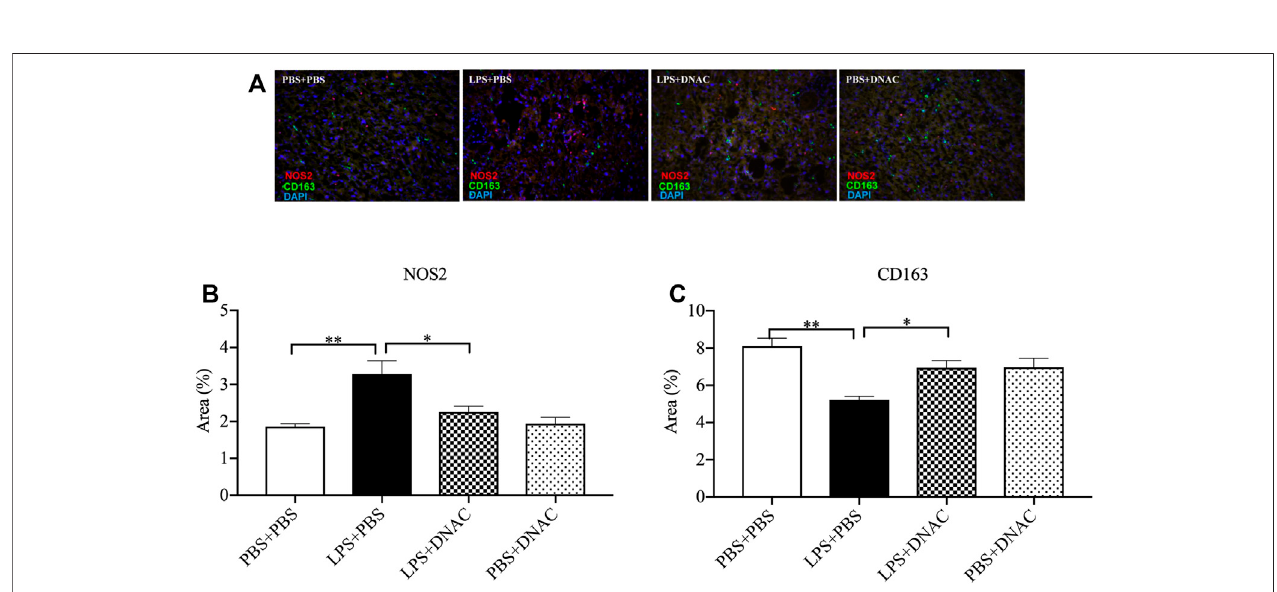
FIGURE 4 | Immunohistochemical staining (IHC) of M1 and M2 macrophages in the placenta following exposure to intrauterine in fl ammation and maternal dendrimer-basedN-AcetylCysteine(DNAC)treatment.Atembryonic(E)day17,pregnantCD-1miceunderwentamini-laparotomyinthelowerabdomenforintrauterine injection of lipopolysaccharide (LPS). One hour later, dams received intraperitoneally injection of DNAC or phosphate-buffered saline (PBS). Placentas were collected at 6hpiafterLPSorPBSinjection.Placentaswerestainedwithanti-NOS2(red,amarkerforM1macrophages)andanti-CD163(green,amarkerforM2macrophage) antibodies.DAPI(blue)stainingidenti fi edthenuclei. (A) RepresentativeimageofIHC.NOS2+ (B) andCD163+ (C) cellswerequanti fi edinthelabyrinthoftheplacentaand werestaticallycomparedbetweengroups.Imagesare × 40magni fi cation,andscalebarsrepresent50 μ m n (cid:1) 5foreachgroup.* p < 0.05** p < 0.01.Datawerereported as Mean ±